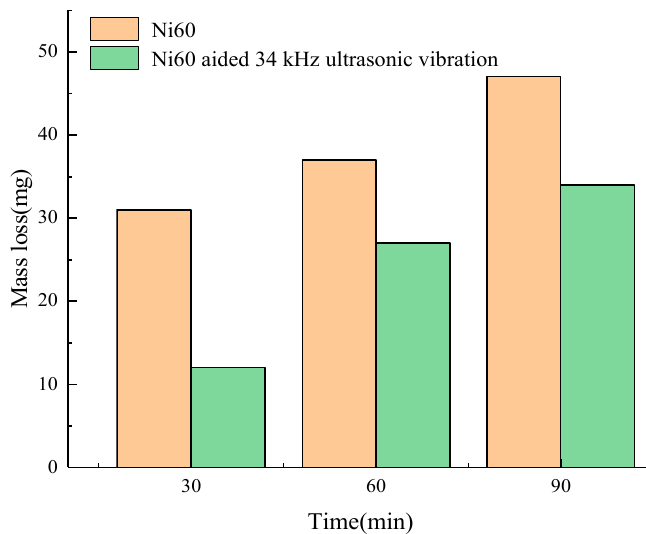
Figure 9. Wear of the cladding layer with or without ultrasonic vibration.